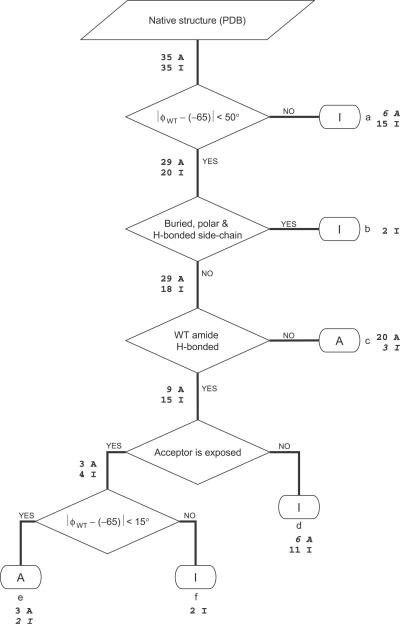
WT Decision TreeThe flowchart of scheme for prediction of effects of Pro mutations on protein stability derived from structural analysis of WT-CcdB crystal structure alone. A and I refer to active and inactive predictions, respectively. The numbers at each branch indicate the number of active and inactive mutants satisfying the “Yes” or “No” criteria of the respective branch. The numbers at each A and I prediction bubble correspond to the number of CcdB Pro mutants ending at that bubble. The numbers of misclassified mutants are shown in italics.